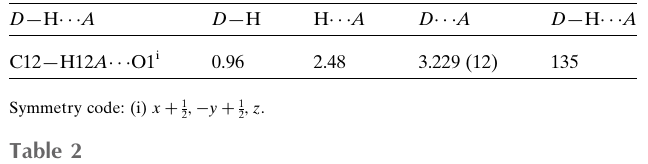
Table 2 Experimental details.